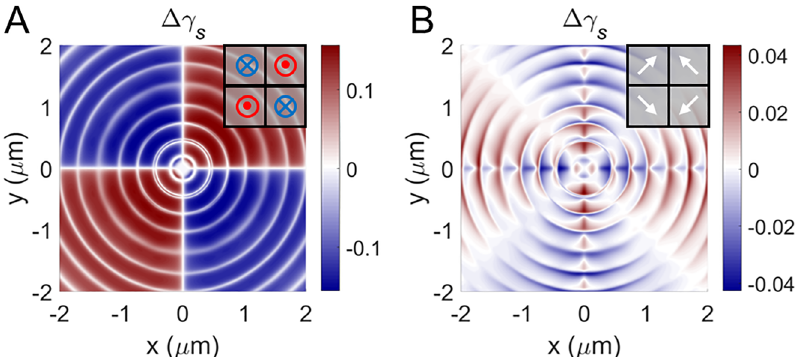
Figure 5: Simulated spatial distributions of Δ γ s for the domain structures with two orthogonal domain walls located at x = 0 and y = 0: (A) Polar magnetization and (B) in-plane magnetization. Inserts show the magnetization orientation in the